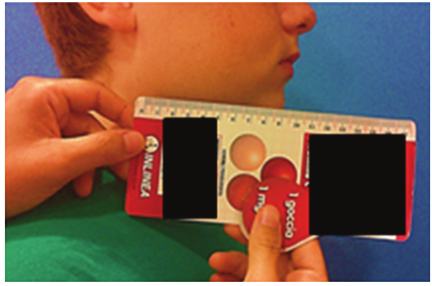
Figure 2: Tumefaction of right mandible